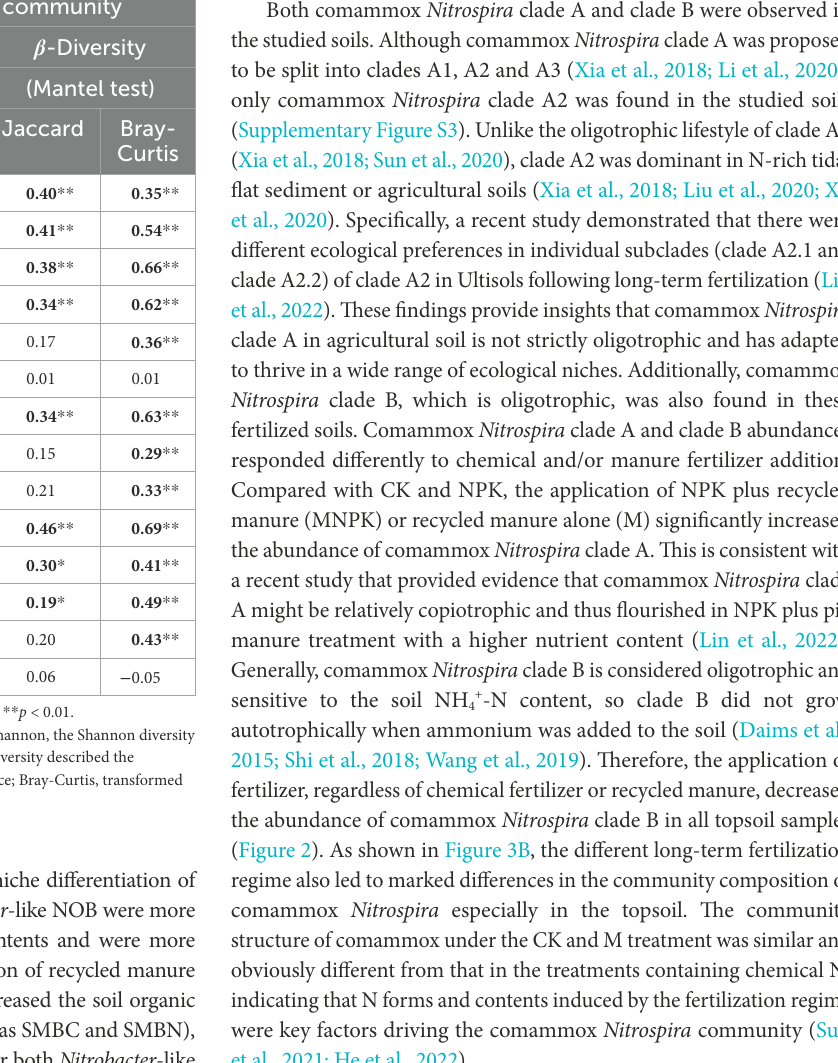
TABLE 3 Correlations between soil properties and comammox Nitrospira community diversity in fertilized soils.